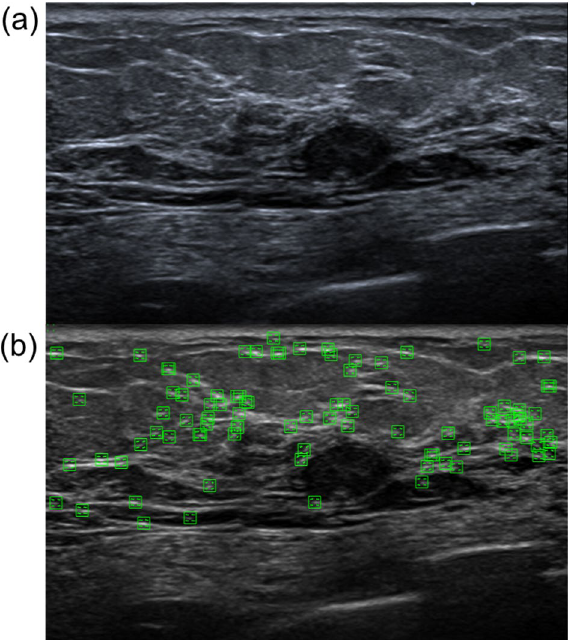
Figure 2. Visualised extracted feature vector from a benign US image by Histogram of Oriented Gradient (HOG). The probably benign (BI-RADS category 3) case: female, age 78 years, a left breast hypoechoic tumour was found and reported by ultrasound imaging, size: 11.7 × 6 mm, location: 2 o’clock from the nipple, distance: 2 cm from the nipple to the lesion. The fibroadenoma lesion was confirmed after a core needle biopsy, size: 1.2 × 0.1 × 0.1 cm. The extracted feature vectors through the HOG descriptor from the image are shown as corner points. ( a ) The US image of this case. ( b ) Green marks represent the positions of corner points obtained from the accelerated segment test